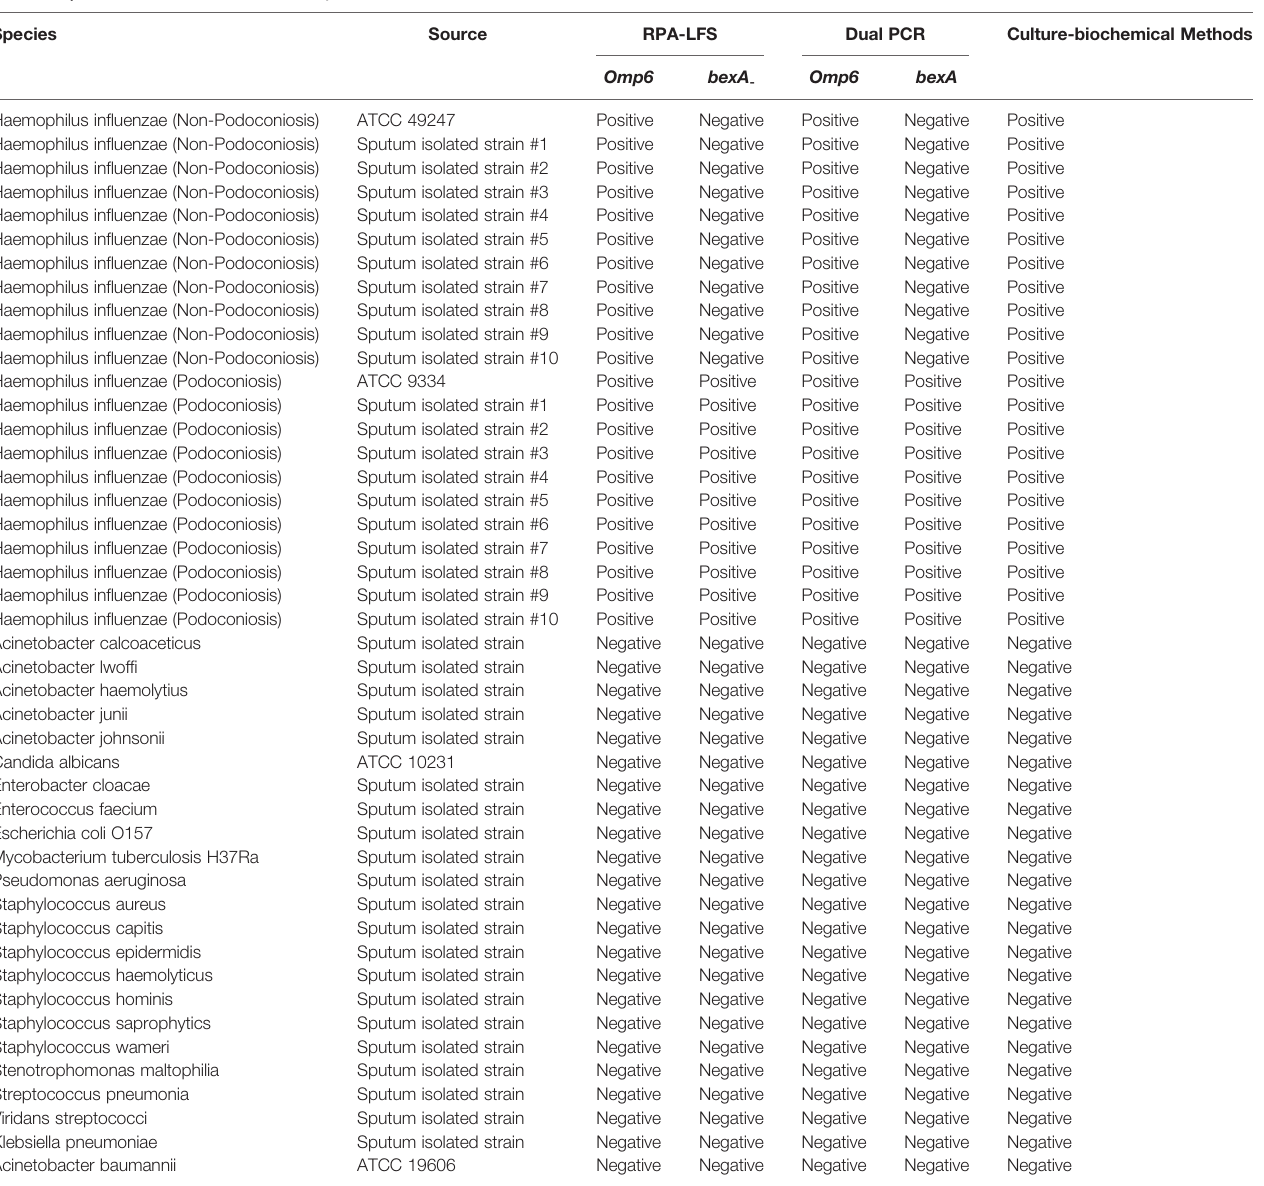
TABLE 2 | Bacterial strains used in the study.